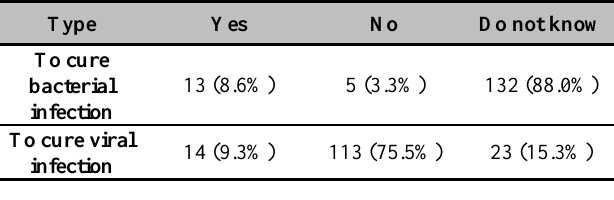
Table 3. Antibiotics use to cure infection